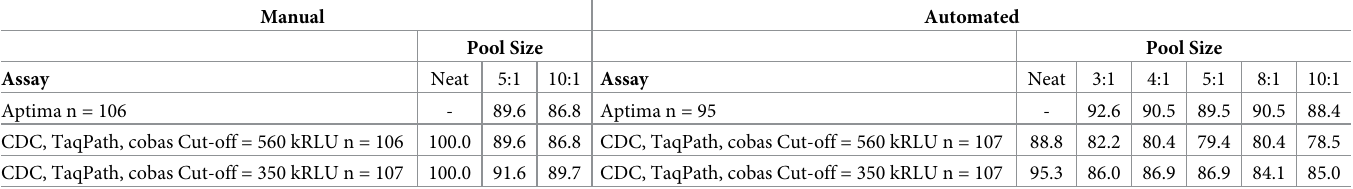
Table 1. PPA between Aptima 1 SARS-CoV-2 pooled sample test results and neat test results from three SARS-CoV-2 assays. Manual